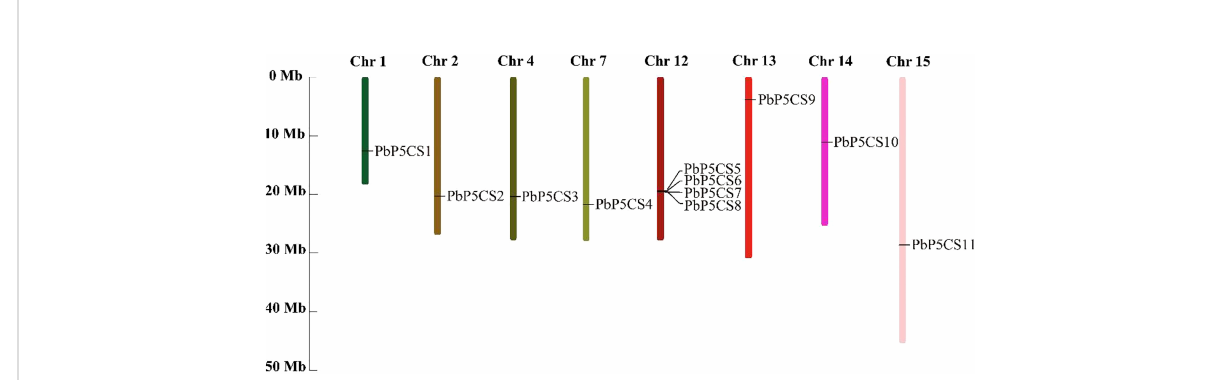
FIGURE 3 Chromosomal distribution of PbP5CS genes. Chromosomal mapping was based on the physical position (Mb) in 17 pear chromosomes. The scale on the left is in megabases (Mb). Chromosome numbers are indicated at the top of each